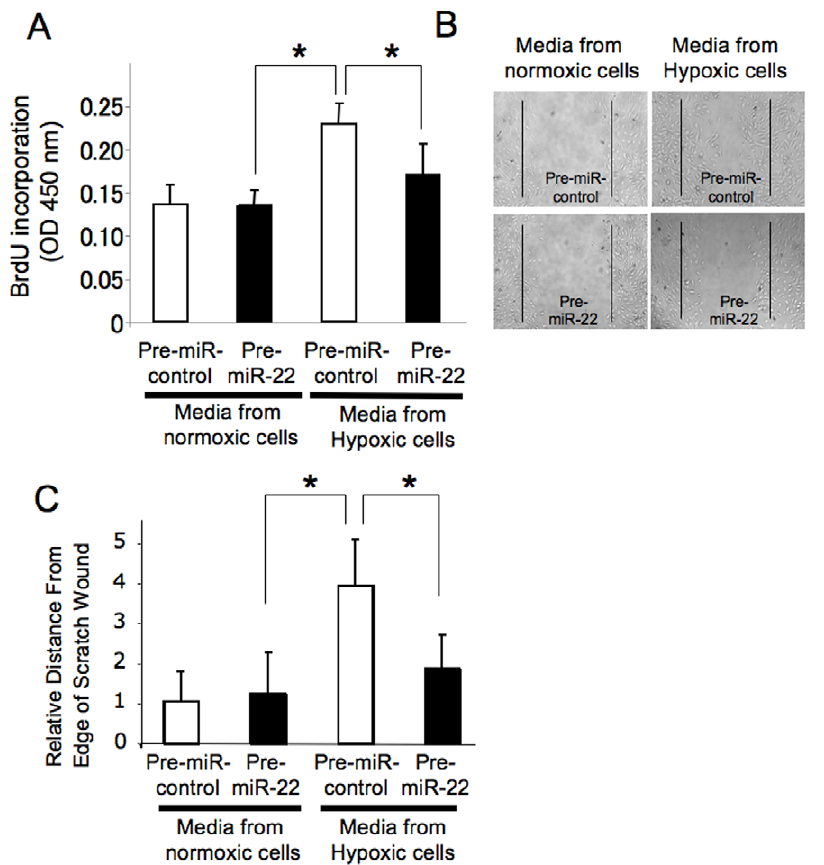
Figure 5. MiR-22 inhibits HCT116 production of VEGF and stimulation of endothelial cells. HCT116 cells were transfected with pre-miR-22 or control, and the media were collected. (A) HUVEC cells were grown in 12 well plates, the conditioned media were added, and the HUVEC were incubated for 3 days. Proliferation was monitored by BrdU incorporation assay (n=5 6 S.D. *P , 0.05). Pre-miR-22 decreases the ability of hypoxic treated cells to produce factors that stimulate endothelial proliferation. (B) HUVEC cells were scratched, the conditioned media were added, and photographed at 16 h. (C) Measurement of the distance covered by each wound relative to the control exposed with normoxia. (*P , 0.05)